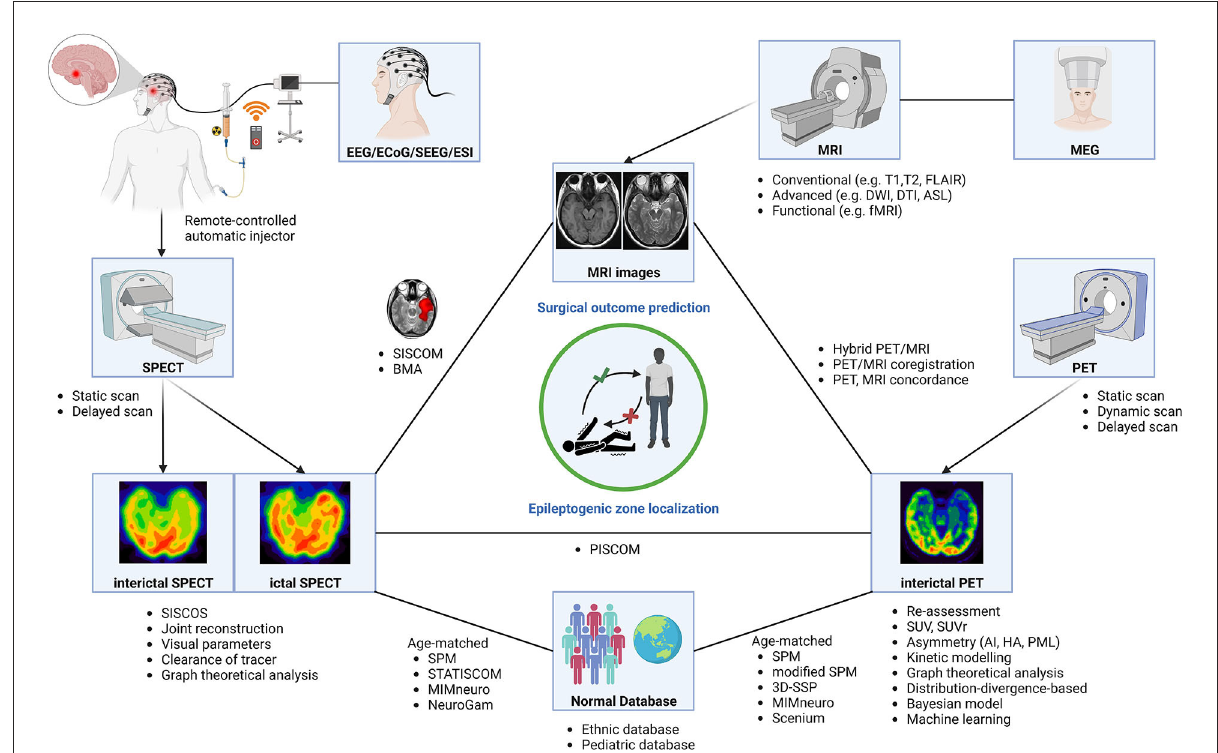
FIGURE3 Neuroimaging modalities using various methods and software for epileptogenic zone localization and surgical outcome prediction. AI, asymmetry index; BMA, Bayesian modeling average; DTI, diffusion tensor imaging; DWI, diffusion-weighted imaging; ECoG, electrocorticography; EEG, electroencephalogram; ESI, EEG source image; ETE, extratemporal lobe epilepsy; fMRI, functional MRI; HA, hypometabolism asymmetry; MEG, magnetoencephalography; MRI, magnetic resonance imaging; PET, positron emission tomography; PML, percentage metabolism loss; SEEG, stereotactic EEG; SISCOS, subtraction ictal SPECT coregistered to interictal SPECT; SISCOM, subtraction ictal SPECT coregistered to MRI; SPECT, single-photon emission computed tomography; SPM, statistical parametric mapping; STATISCOM, statistical ictal SPECT coregistered to MRI; SUV, standard uptake value; SUVr, SUV ratio; 3D-SSP, three-dimensional stereotactic surface